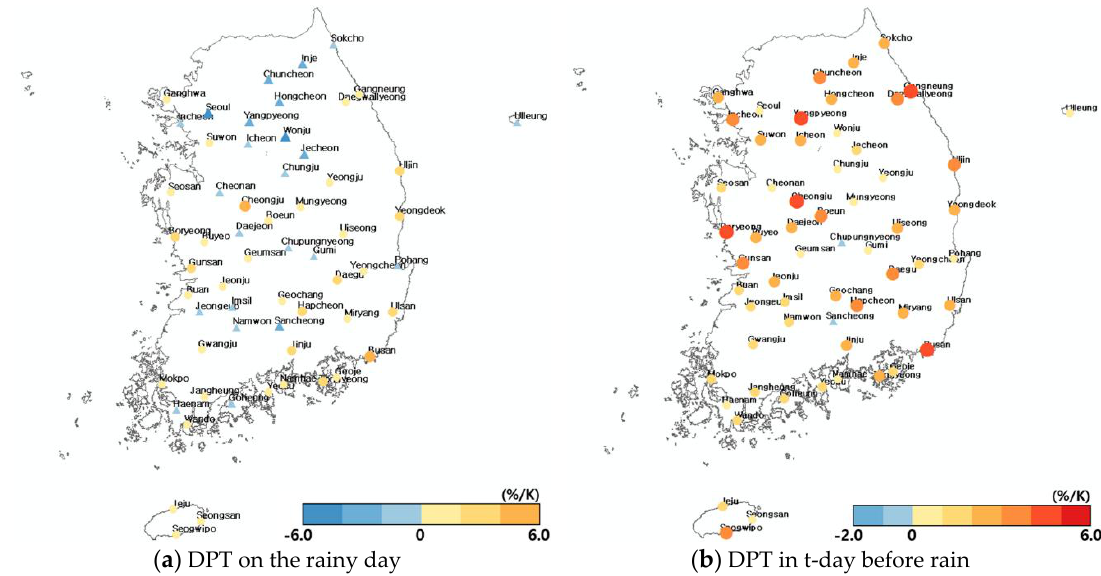
Figure 7. Sensitivity of annual exceedance daily rainfall depth to DPT in all sites.